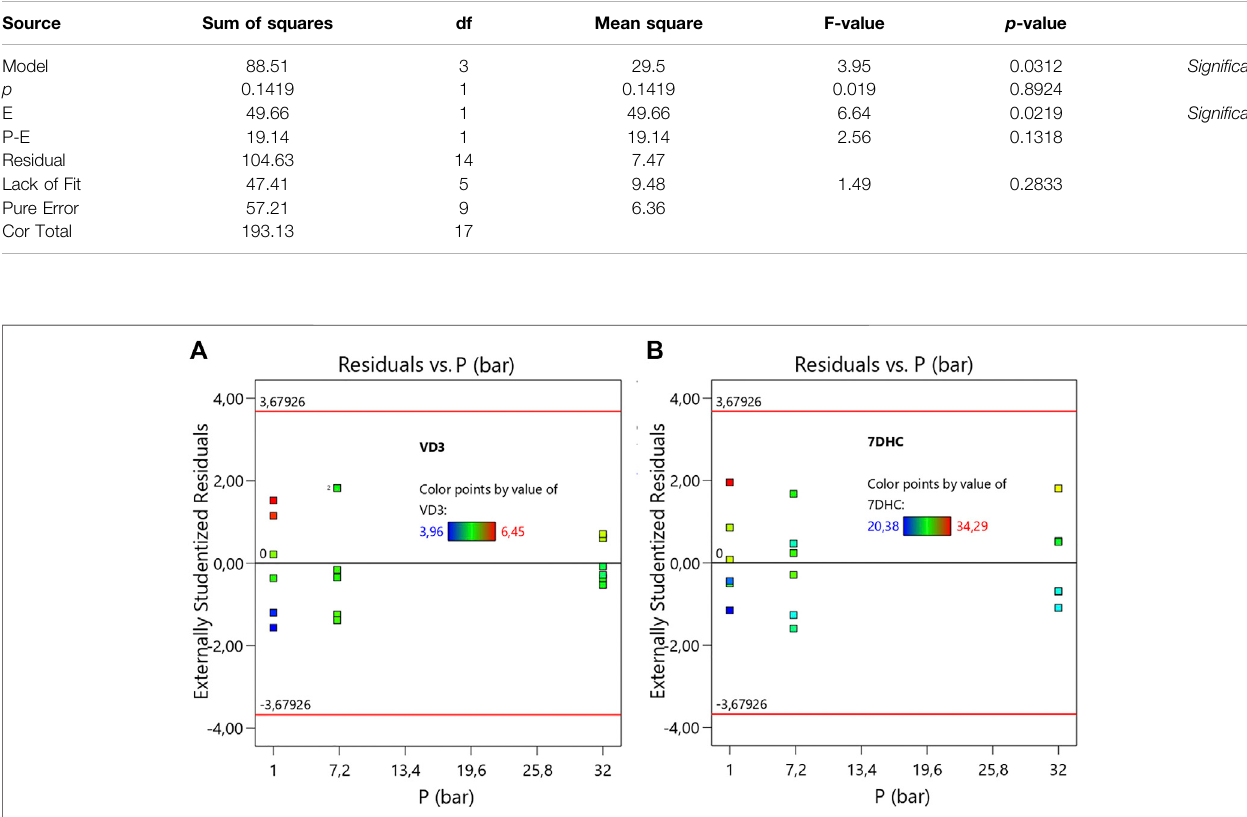
FIGURE 3 | Normalized residuals plot of VD3 (A) and 7DHC (B) with respect of pressure ( p ). ( Average points in green. In blue and in red the lower and the upper leveraged values respectively )